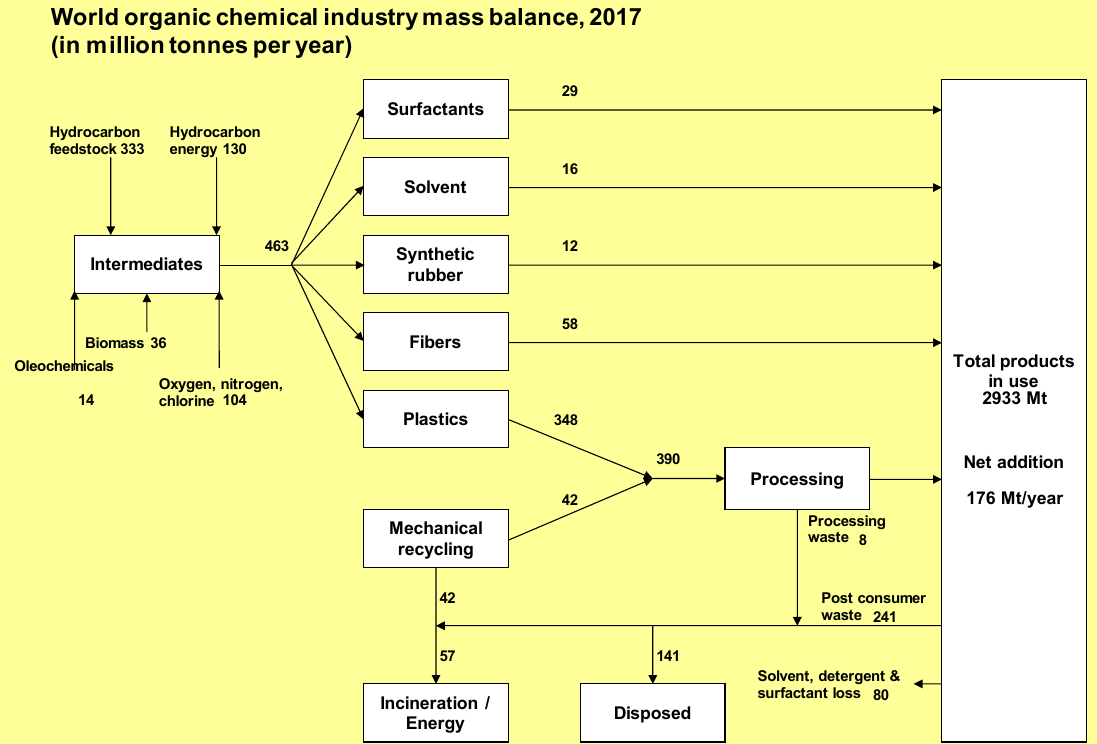
Figure 1. Estimated world petrochemicals production, processing and recycling balance, 2017. Source: updated to the year 2017 based on Ref [6].